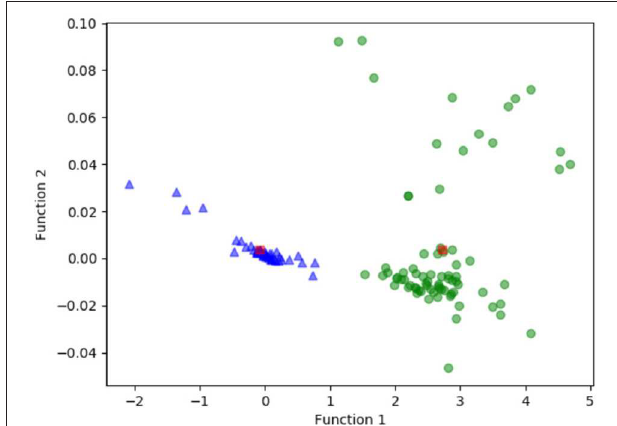
FIGURE 3 | Relationship between the canonical discriminative functions from LASSO + LDA models for the glioblastoma and ANA groups (triangles and circles) and for the group centroids (squares). Minimal overlapping was observed in this figure. Qualitatively, analysis of the data selected by LASSO could separate glioblastoma from ANA. LASSO, least absolute shrinkage and selection operator; LDA, linear discriminant analysis; ANA, Anaplastic